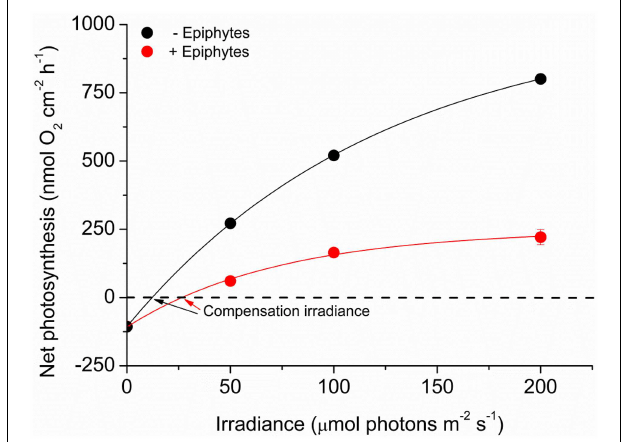
FIGURE 6 | Net photosynthesis rates as a function of downwelling photon irradiance. Rates were calculated for the four different incident irradiances (0, 50, 100, and 200 µ mol photons m − 2 s − 1 ) and were fitted with a hyperbolic tangent function (Webb et al., 1974) with an added term to account for respiration ( Spilling et al., 2010) ( R 2 = 0 . 99 ). Red symbols and line represent leaves with ∼ 21% epiphyte-cover. Black symbols and line represent leaves without epiphyte-cover. Error bars are ± SD. n = 3 –4; leaf level replicates.